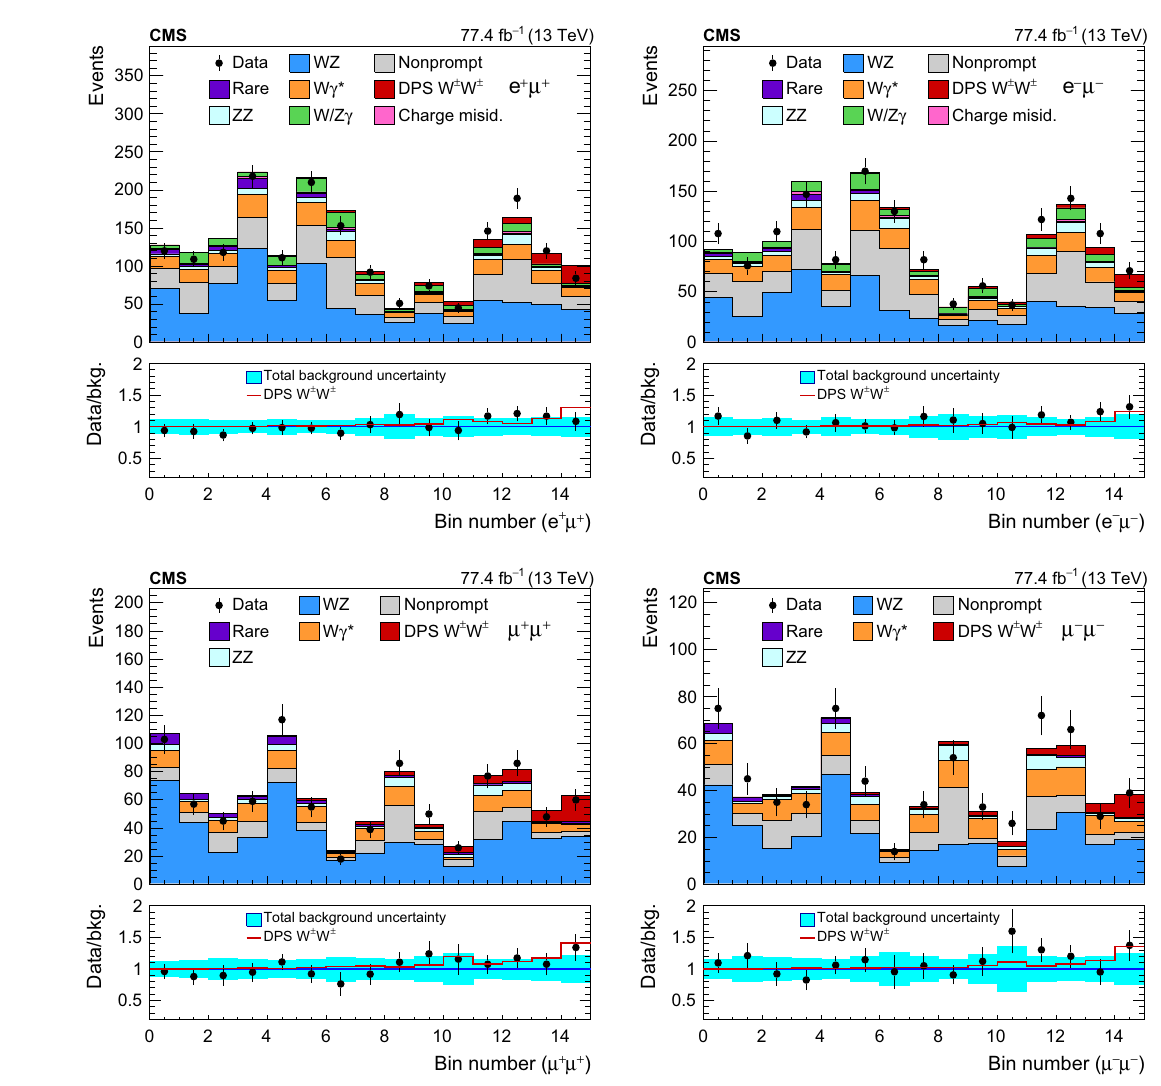
in the “Rare” background category. The bottom panels show the ratio of data to the sum of all background contributions in the black markers along with the signal shown using a red line. The band represents the postfit background uncertainty, which includes both the statistical